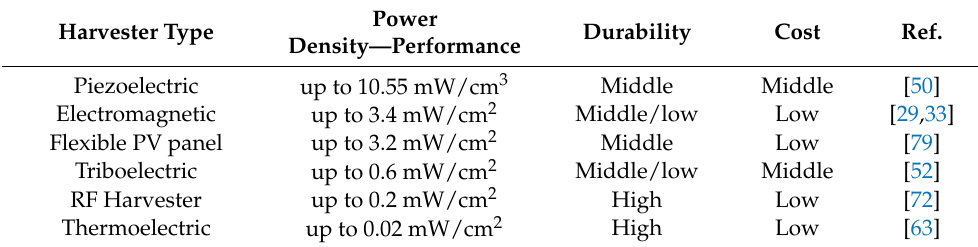
Table 10. Comparison of fundamental parameters for different harvesting methods based on demon- strators presented in particular papers. Power Harvester Type